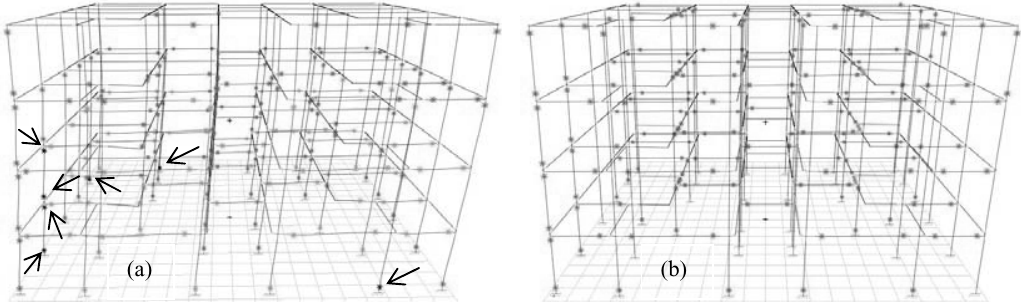
Fig. 3. Plastic hinge distributions for: (a) Existing building; (b) STR-BSO